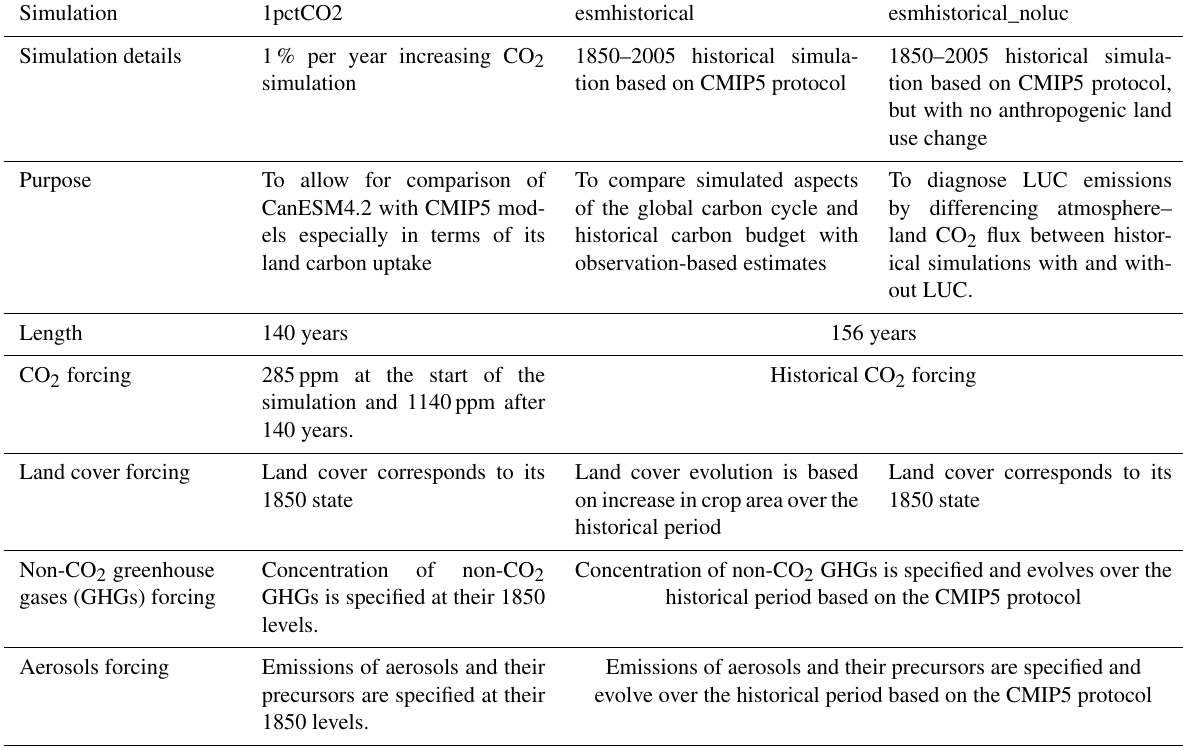
Table 1. Summary of simulations performed for this study and the forcings